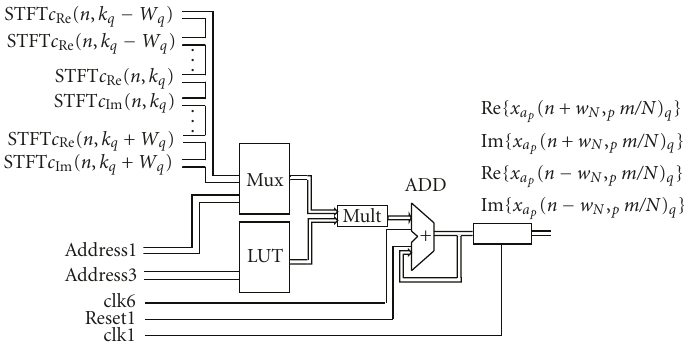
Figure 11: Serial architecture for producing of signal with complex-lag argument (Block21).